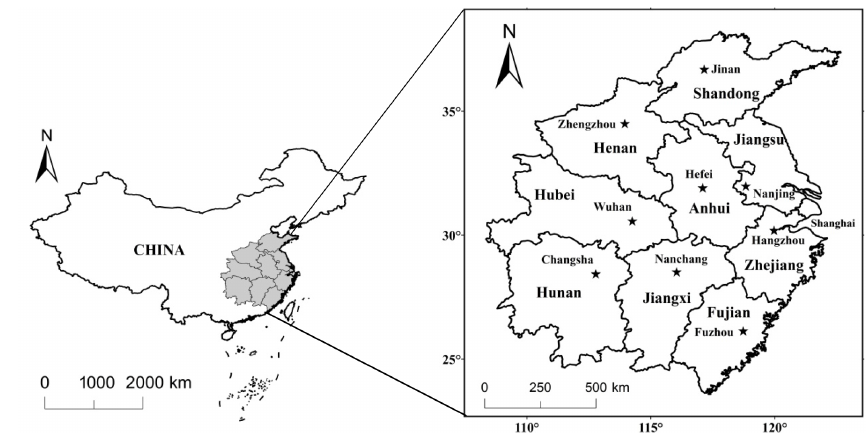
Figure 1. Locations of central and eastern China and the key